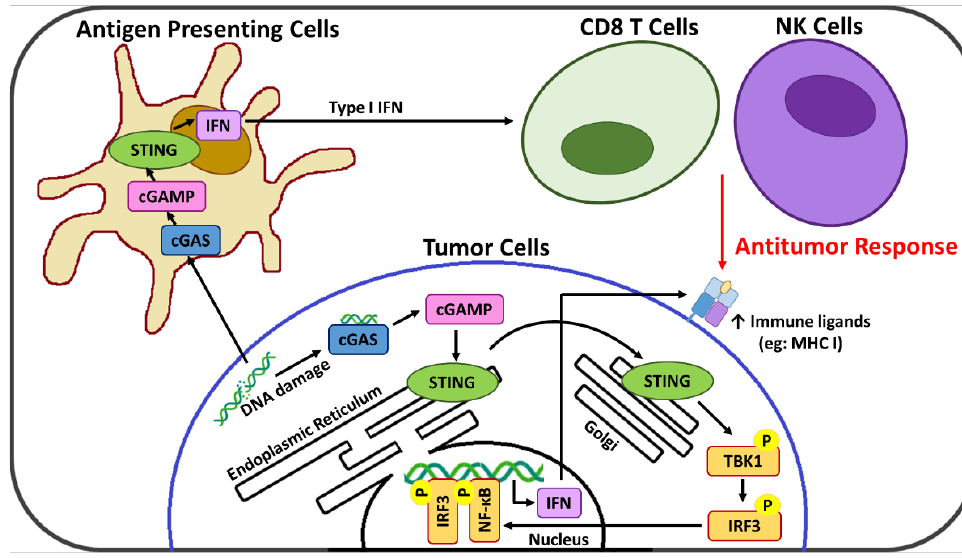
Figure 1. Summary of the cGAS-STING pathway and its role in cancer immunosurveillance.